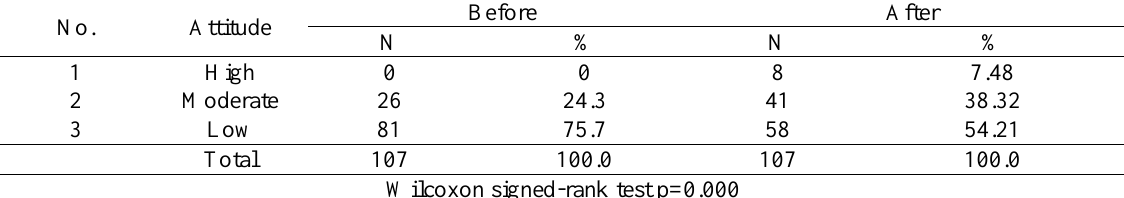
Table 2. Differences in attitute of respondents pre- and post-intervention